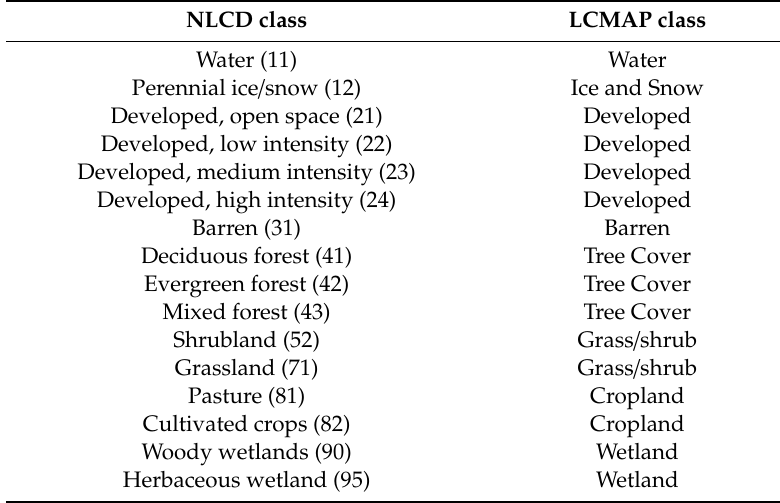
Table 1. The cross-walk from National Land Cover Database (NLCD) to Land Change Monitoring, Assessment, and Projection (LCMAP) classes. The values in parentheses are the NLCD land cover class